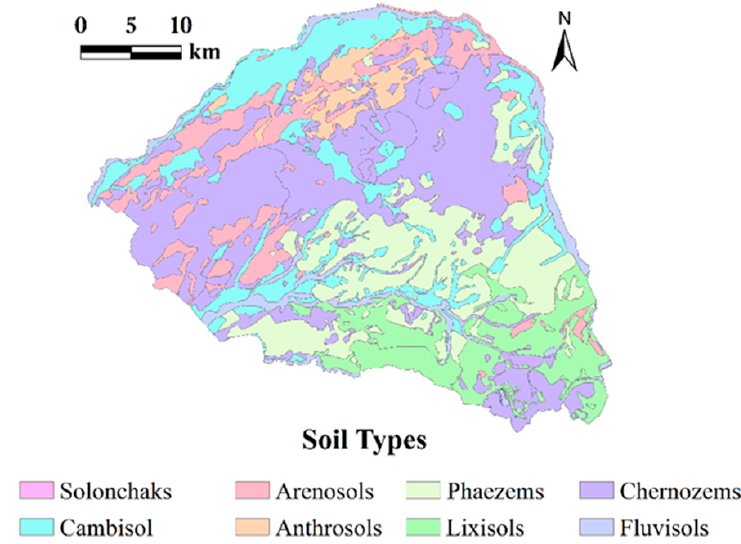
Figure 2. Distribution of soil types in Lishu County, Jilin Province. Table 1. Chemical fertilizer inputs in Lishu County in different years.